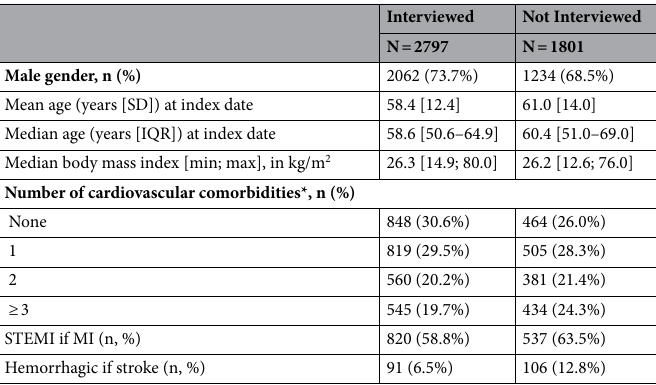
Table 1. Characteristics of eligible patients with incident myocardial infarction or stroke (interviewed or not). *Hyperlipidemia, hypertension, heart failure, diabetes mellitus. MI myocardial infarction, SD standard deviation, STEMI ST segment elevation myocardial